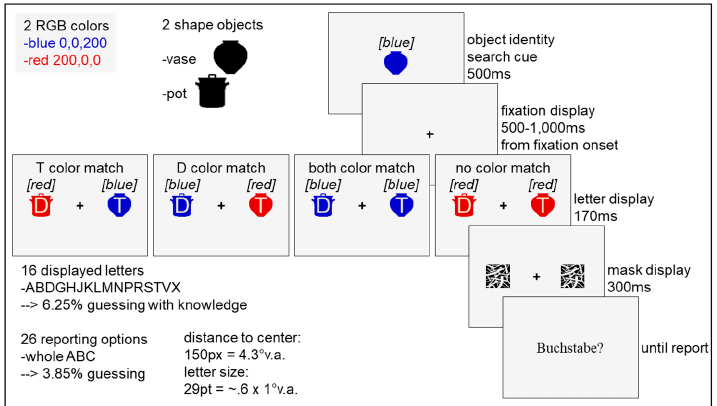
Figure 1. Material, procedure, and design of Experiment 1. Only the target (T color match), only the distractor (D color match), both (both color match), or no object (no color match) of the letter display matched the cue’s irrelevant color. The color words in brackets are added for greyscale